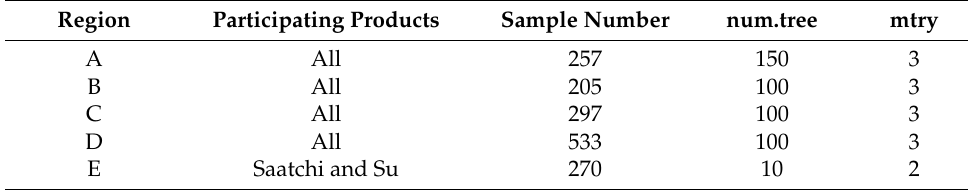
Table 1. The participating AGB datasets, the number of samples available for calibrating and evaluating the RF models in each region, and the hypertuning parameters that were used to build the RF model in each region, including the number of decision trees (num.tree) and the number of products available for splitting at each tree node (mtry). Region Participating Products Sample Number num.tree mtry A All 257 150 3 B All 205 100 3 C All 297 100 3 All